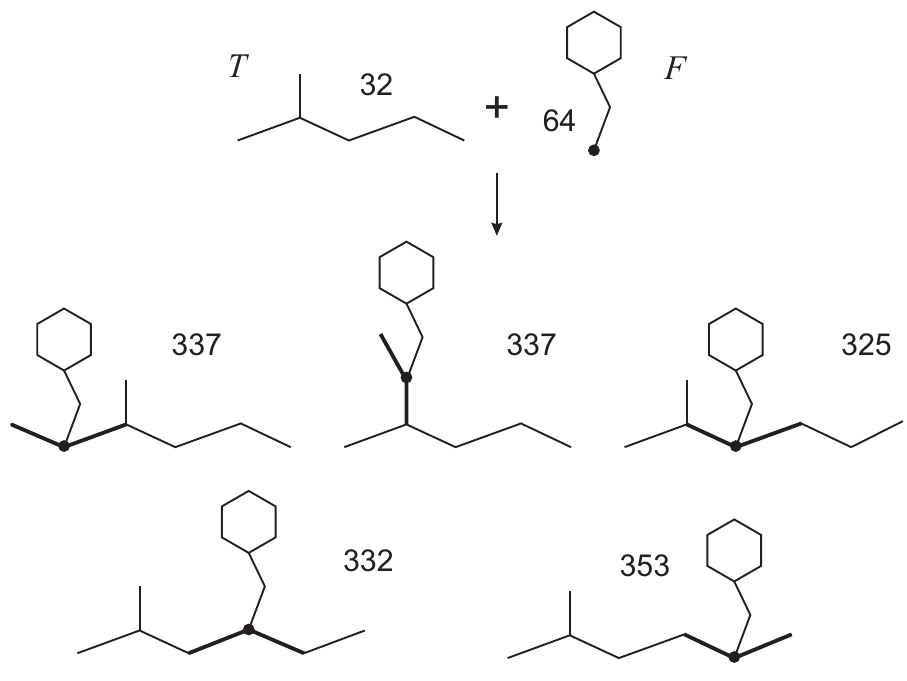
Figure 3: Family E of unicyclic graphs with W ( E ) = 1684